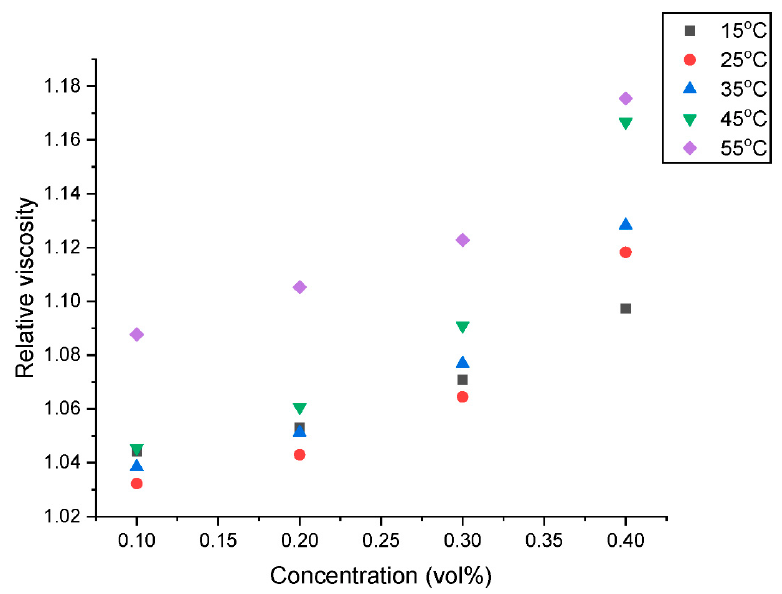
Figure 7. Influence of concentration on the relative viscosity of the hybrid nanofluids at various temperatures.